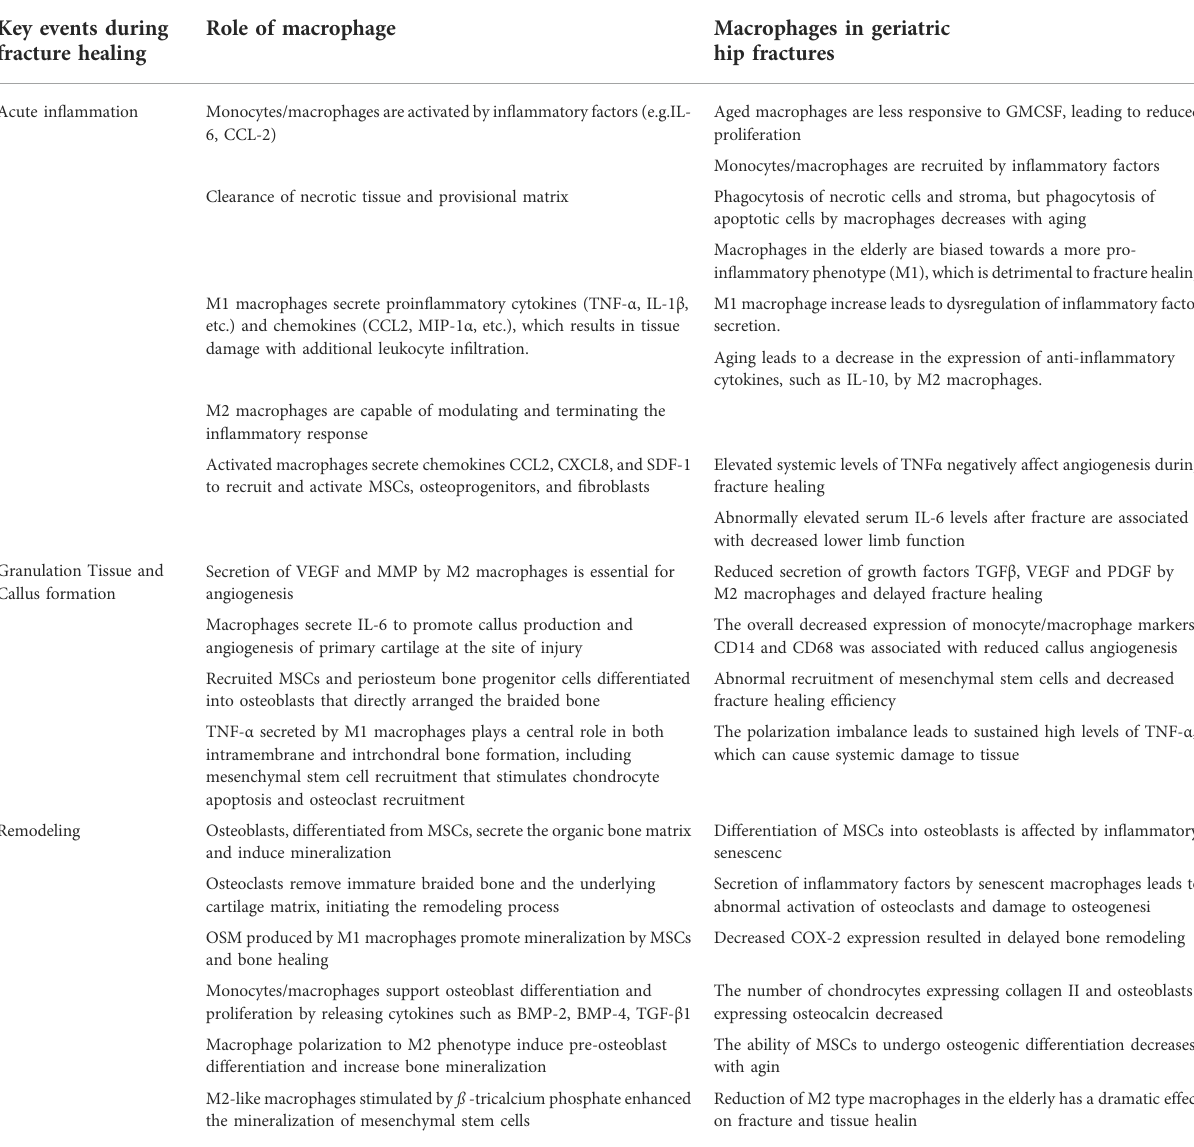
TABLE 1 Role of monocyte/macrophage in geriatric hip